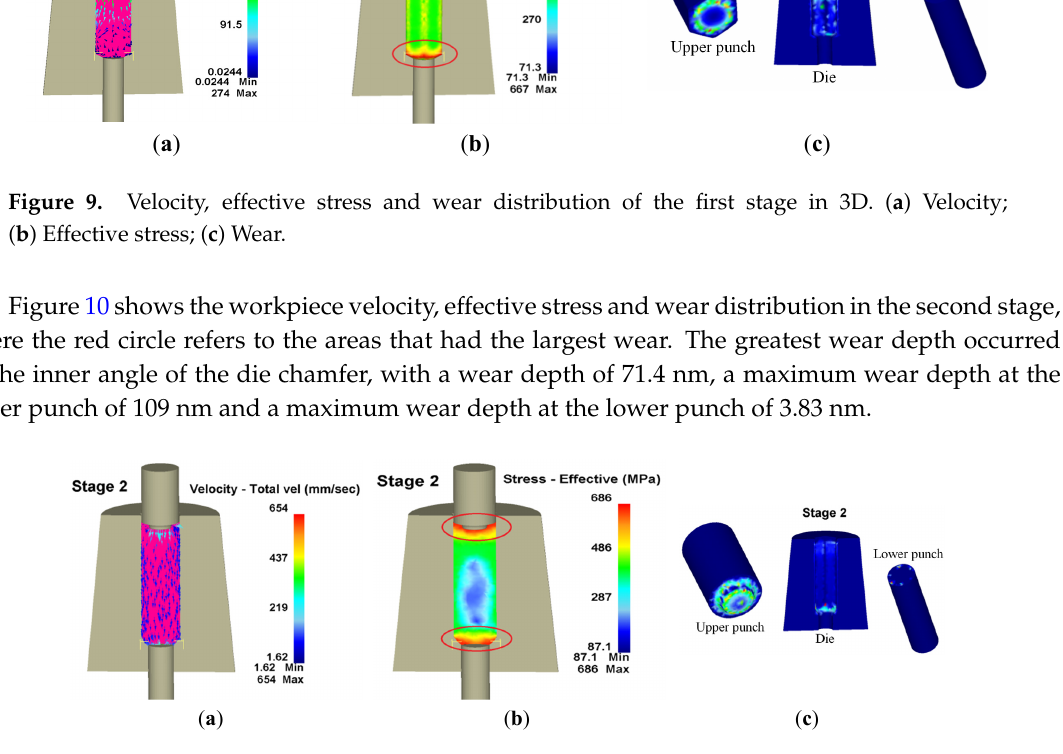
( c ) Figure 12. Velocity, effective stress and wear distribution of the fourth stage in 3D. ( a ) Velocity; ( b ) Effective stress; ( c ) Wear. Figure 13 displays workpiece velocity and stress, as well as wear distribution at the fifth stage, where the largest wear occurs in the red circle. Maximal die wear depth occurred at the upper punch with a wear depth of 472 nm, a maximum die wear depth of 15.4 nm and a maximum wear depth at the lower punch head of 67.3 nm.